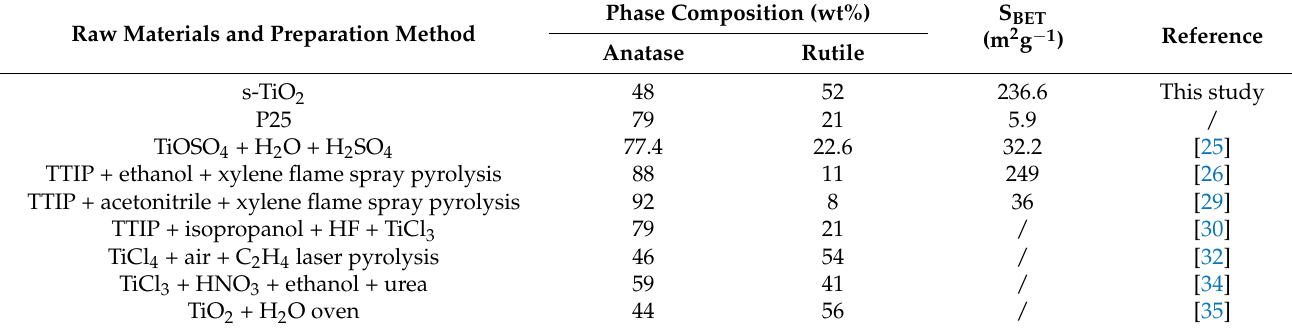
Table 2. Microstructural characteristic and rate constants of mixed-phase TiO 2